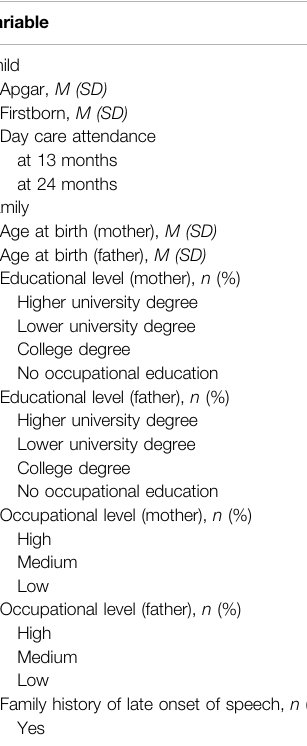
TABLE 1 | Descriptive overview of participants in the study. Comparison between background variables as a function of the child´s sex. t -test (conducted for continuous variables) denoted by mean ( SD ), and Chi-square test (conducted for categorical variables) is presented by n (%).